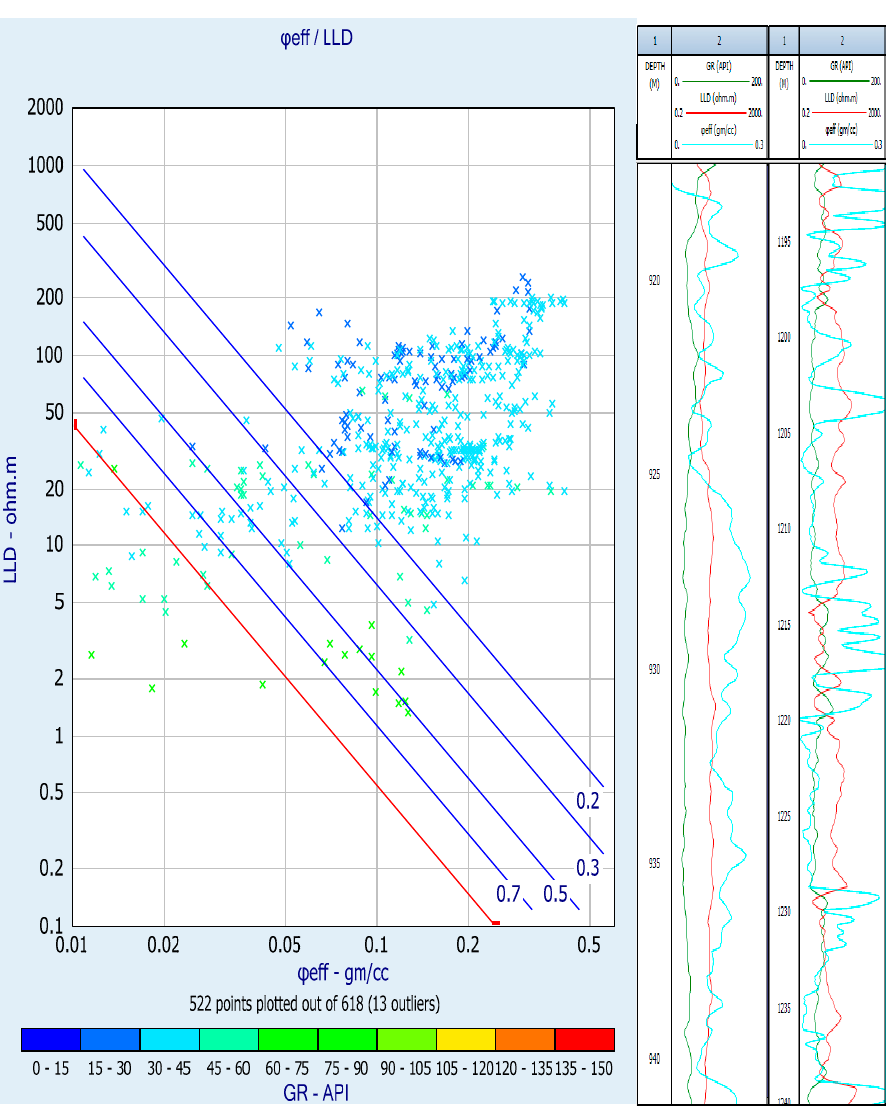
Figure 9. QGF well 03 Pickett plot of Φ eff via LLDs with a gamma-ray response. API—American Petroleum Institute.